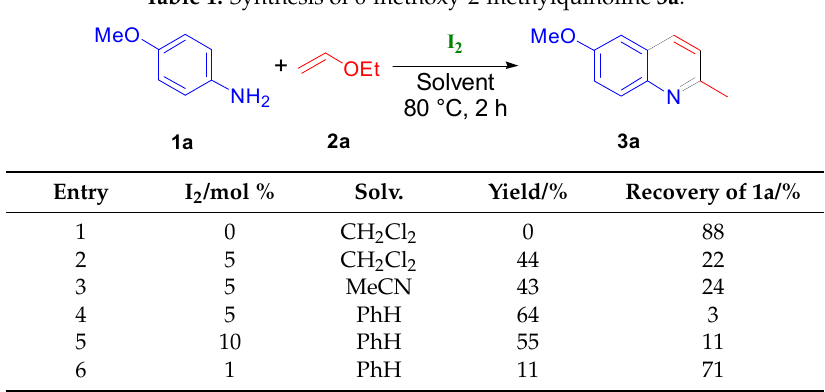
Table 2. Modification of the benzene ring of quinoline 3 .